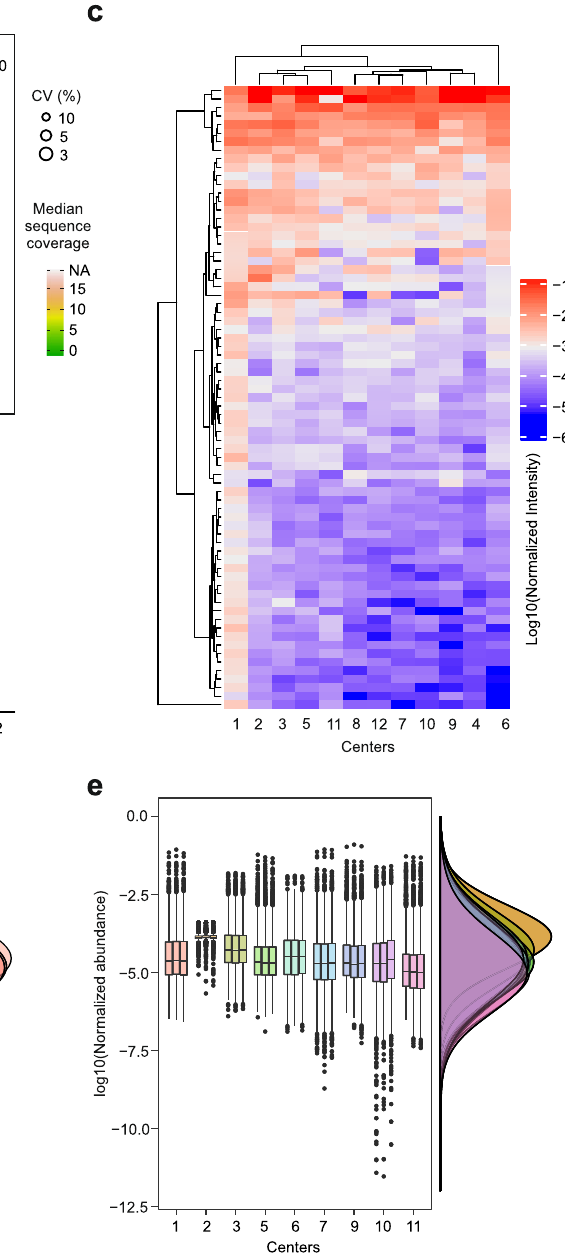
between the 12 cores. d Distribution of protein-level intensities for the 12 cores. e Distribution of peptide level intensities for 10 cores, as cores 4 and 12 did not providepeptidelevelintensities(centerline,median;boxlimitscontain50%;upper and lower quartiles, 75 and 25%; maximum, greatest value excluding outliers; minimum,leastvalueexcludingoutliers;outliers,morethan1.5timesofupperand lower quartiles). All analyses were based on three technical